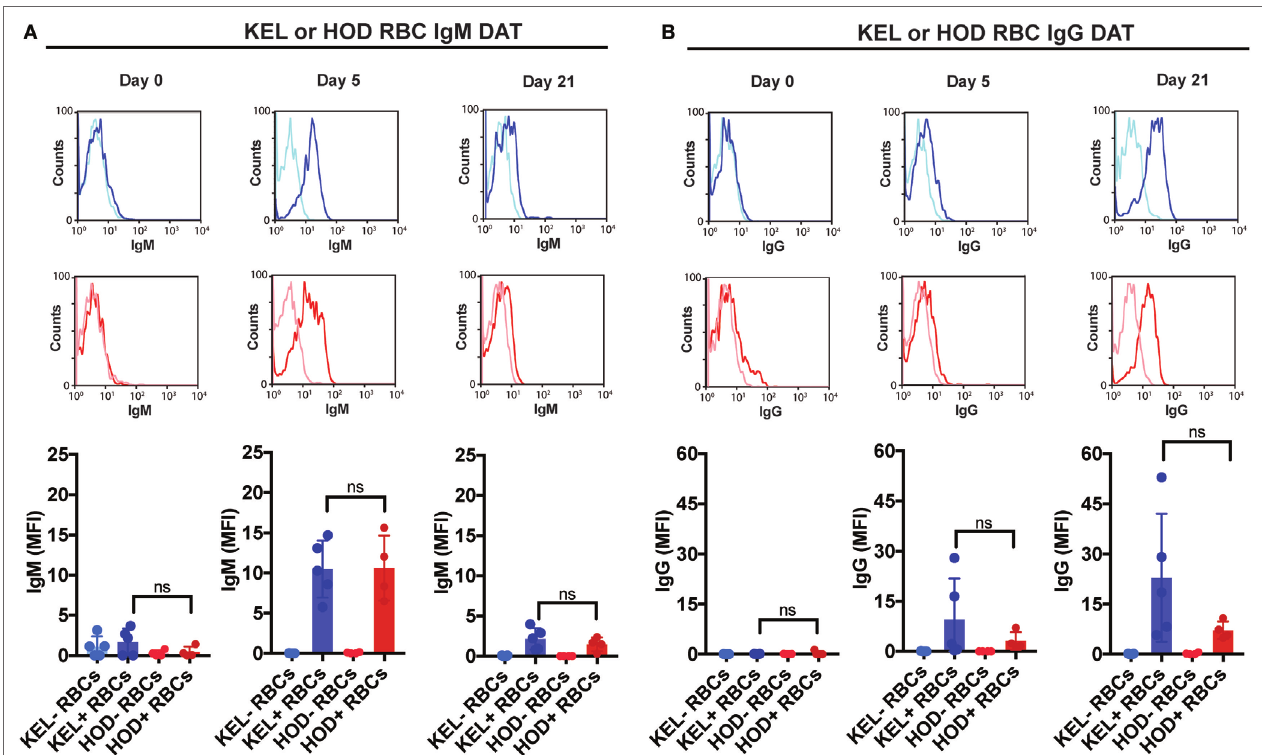
FigUre 4 | IgM and IgG specifically deposit on KEL or HOD red blood cells (RBCs) at similar levels post-transfusion. (a) KEL-negative RBCs (KEL − RBCs), KEL-positive RBCs (KEL + RBCs), HOD-negative RBCs (HOD − RBCs) or HOD-positive RBCs (HOD + RBCs) were evaluated at days 0, 5, and 21 post-transfusion for surface engagement of IgM by flow cytometry in B6 mice. (B) KEL-negative RBCs (KEL − RBCs), KEL-positive RBCs (KEL + RBCs), HOD-negative RBCs (HOD − RBCs) or HOD-positive RBCs (HOD + RBCs) were evaluated at days 0, 5, and 21 post-transfusion for surface engagement of IgG by flow cytometry in B6 mice. (a,B) ns = not significant. Means ± SD